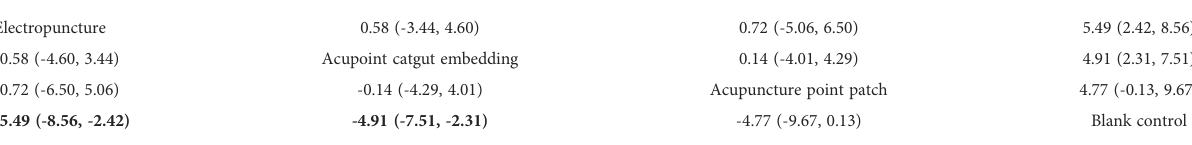
TABLE 8 Network meta-analysis ladder table of waistline. Electropuncture